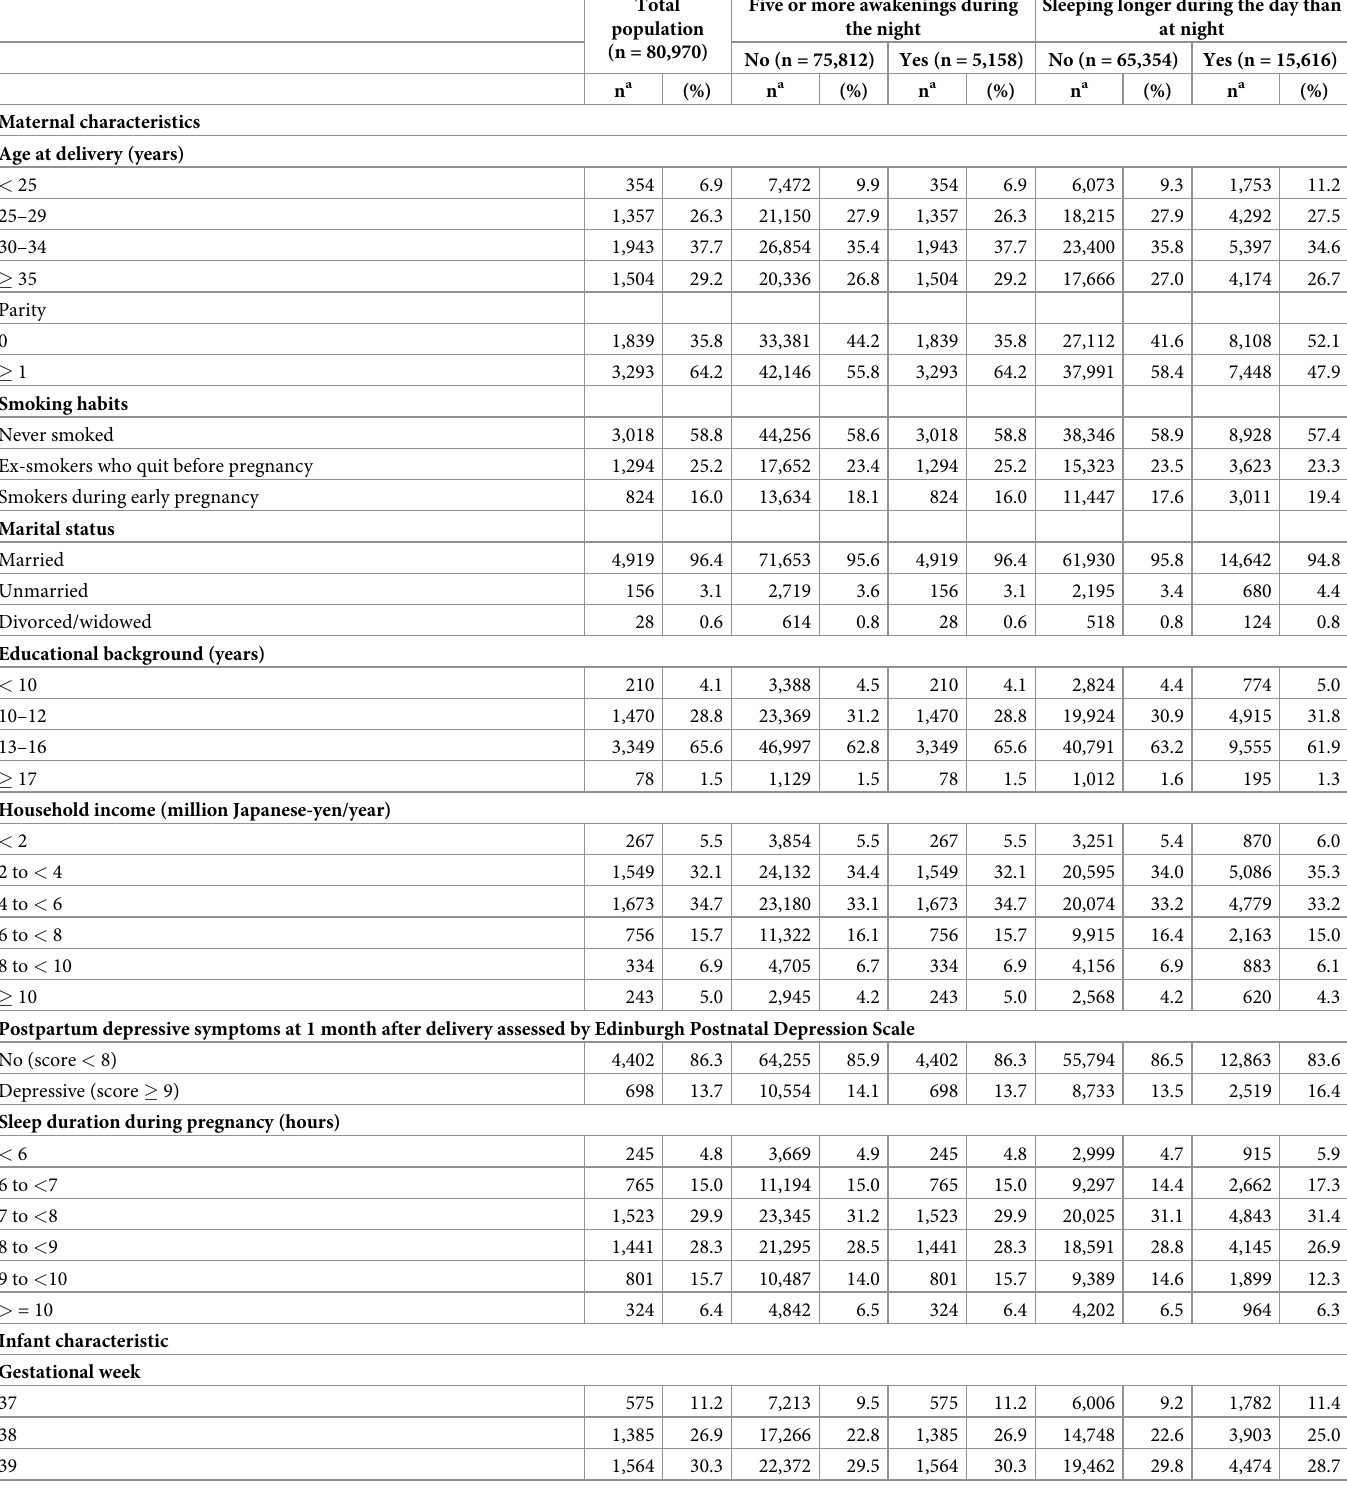
Table 1. Characteristics of the study